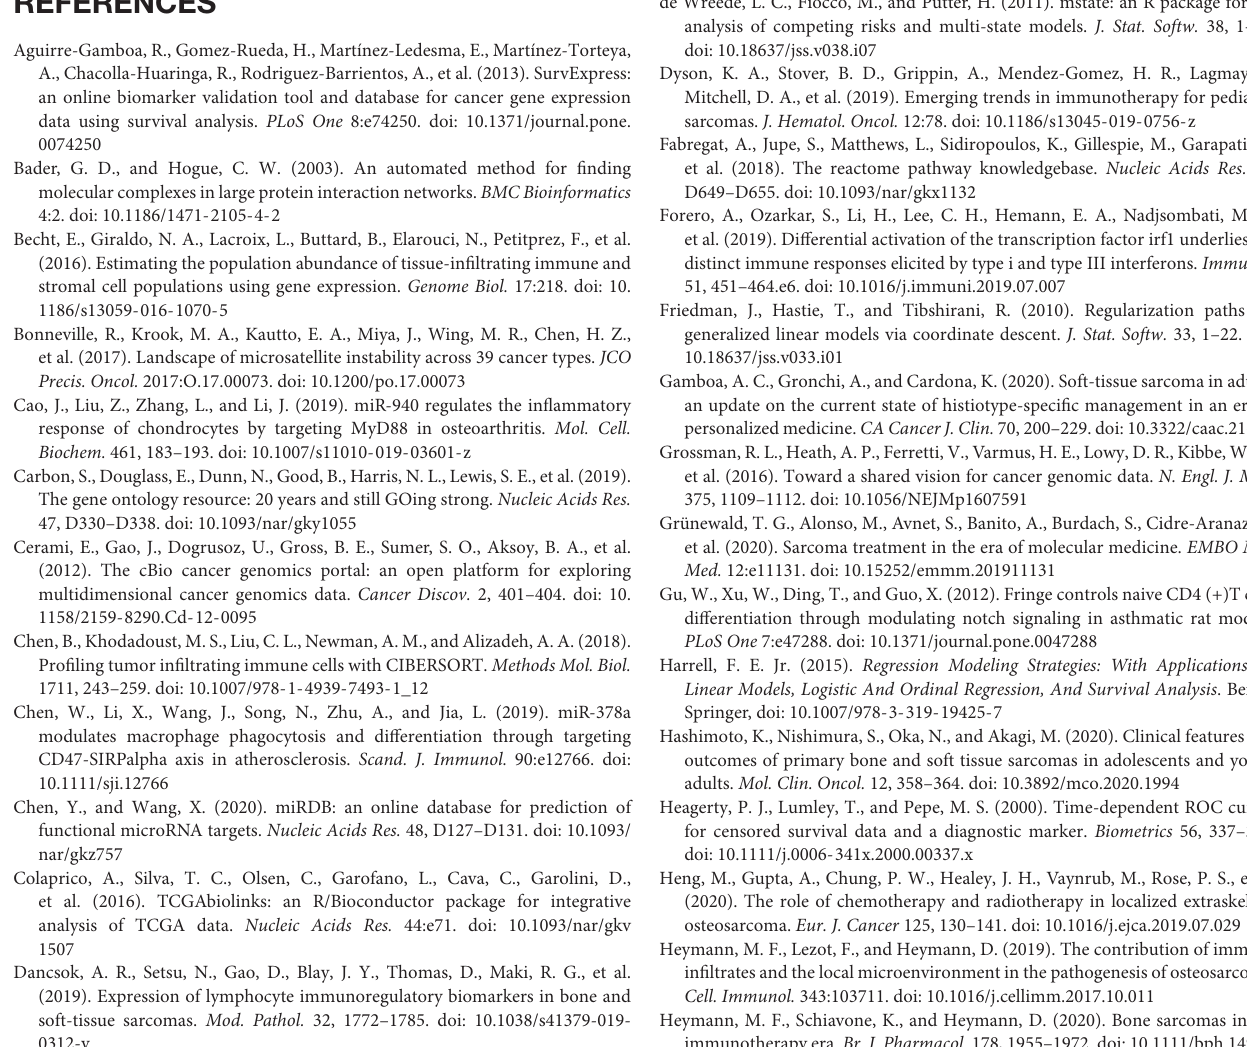
survival in the testing cohort. (E) Nomogram for predicting the survival probability of 1-, 3-, and 5-year overall survival in the testing group. (F) time-dependent ROC curves for the Nomogram in the testing group. (G) time-dependent ROC curves for the Nomogram in the training group. (H) The time-dependent calibration plots for the nomogram in 1,3,5-year time periods in the testing group. (I) The plot of DCA analysis for assessing clinical judgment utility of the risk score model and nomogram in the total TCGA sarcoma cohort. Supplementary Figure 6 | Multidimensional validation of the risk score model in external databases. (A,B) Expression of Both IRF1 (A1–A7) and MFNG (B1–B13) were downregulated in sarcomas compared to non-tumor tissues in Oncomine database. (C) R2: Genomics Analysis and Visualization Platform: both expression levels of IRF1 and MFNG were negatively associated with patients’ metastasis-free survival and overall survival in osteosarcomas (datasets: GSE42352). (D) SurvExpress: both expression levels of IRF1 and MFNG were negatively associated with patients’ metastasis-free survival in various sarcomas (datasets: GSE21050). (E) LOGpc: expression level of MFNG was negatively associated with patients’ metastasis-free survival in various sarcomas (datasets: GSE71118). (F) the mRNA expression levels of IRF1 and MFNG in exosomes were validated in human blood exosomes compared to multiple tumor tissues by using the exoRBase